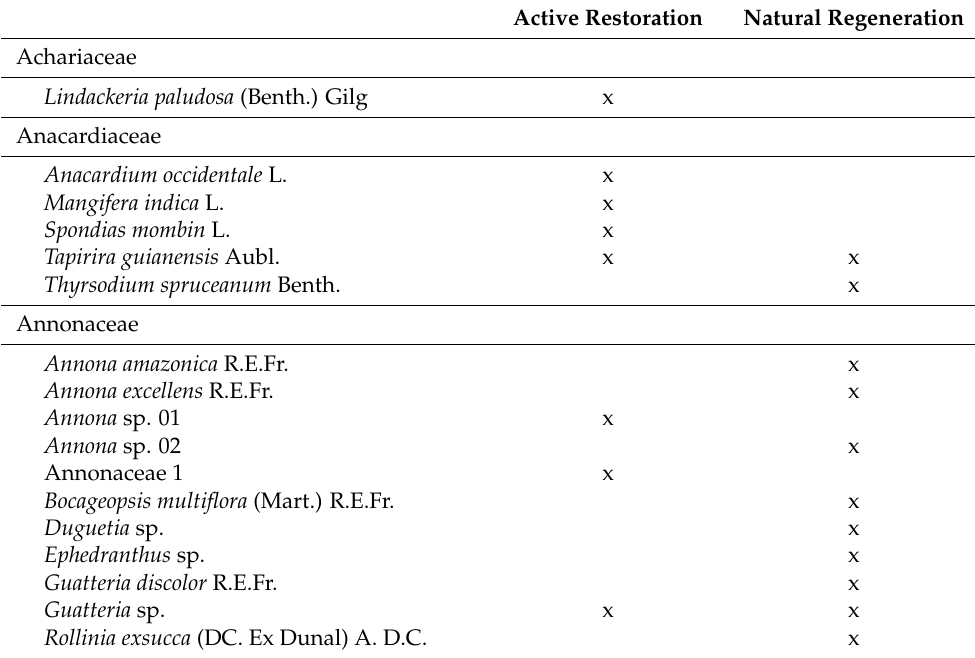
Table A2. List of species sampled in active and natural regeneration sites, located south of Jirau Hydroelectric Reservoir, along the upper Madeira